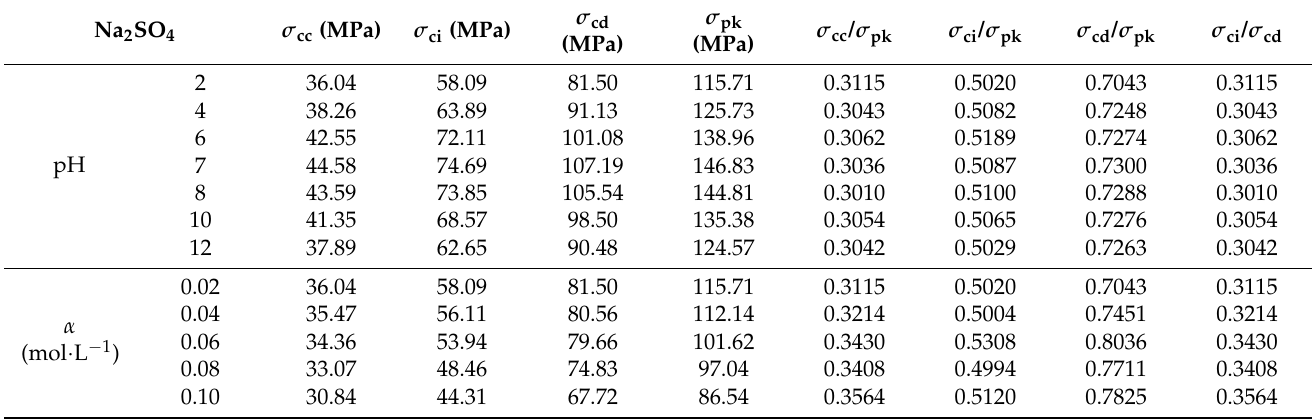
Table 3. Characteristic stress of Na 2 SO 4 corroded sandstone ( σ 3 = 10